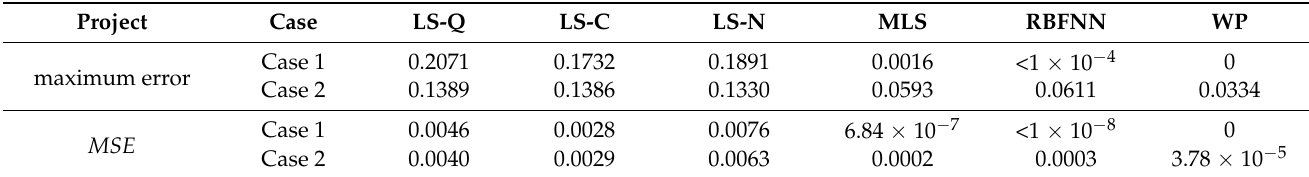
Figure 4. Accuracy comparison of fitting results for ( a ) TD1 in Case 1, ( b ) TD1 in Case 2, ( c ) TD2 in